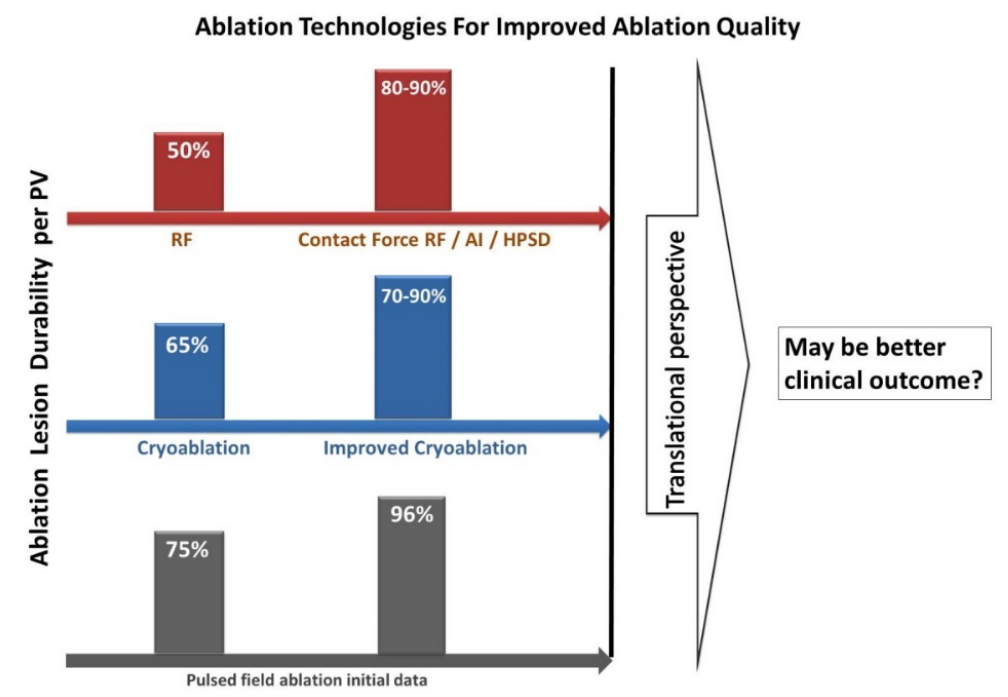
Figure 7. Ablation Concepts Additionally, Technologies For Improved Ablation Quality.